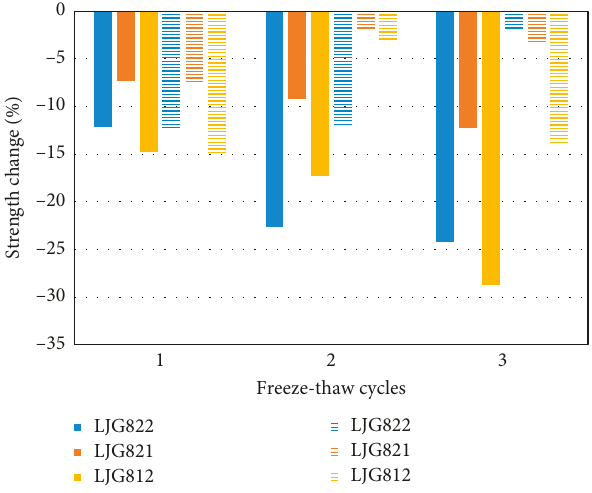
Figure 7: Percentage strength change with freeze-thaw